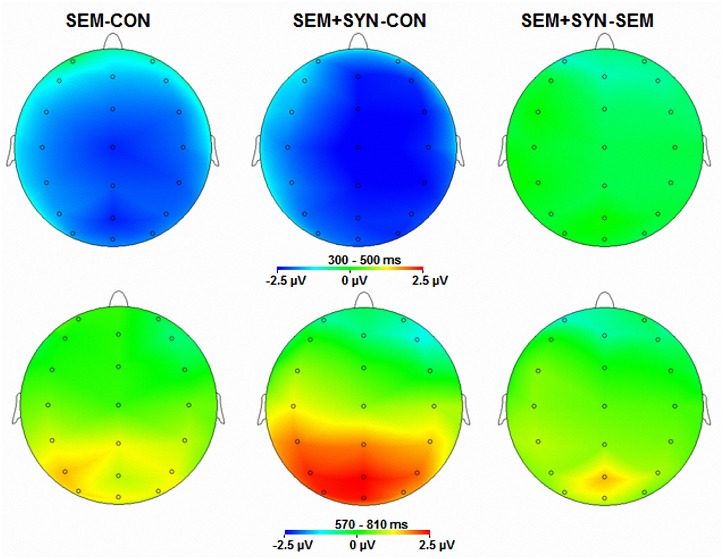
Topographic distributions of the mean ERP differences from 300 to 500 ms and those from 570 to 810 ms, respectively.“SEM-CON” = difference between SEM and CON, ‘‘SEM+SYN-CON” = difference between SEM+SYN and CON, and ‘‘SEM+SYN-SEM” = difference between SEM+SYN and SEM.